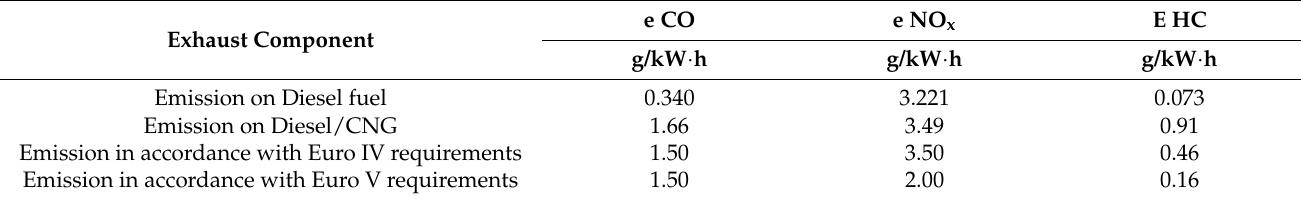
Table 7. The obtained results of emissions of individual exhaust gas components and the applicable Euro IV and Euro V standards